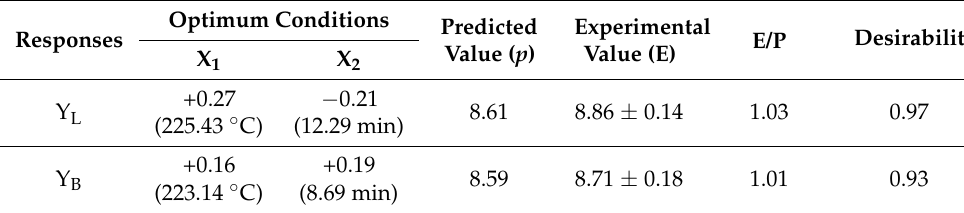
Table 4. Optimum conditions for superheated steam-treated chicken products using response surface methodology. Responses